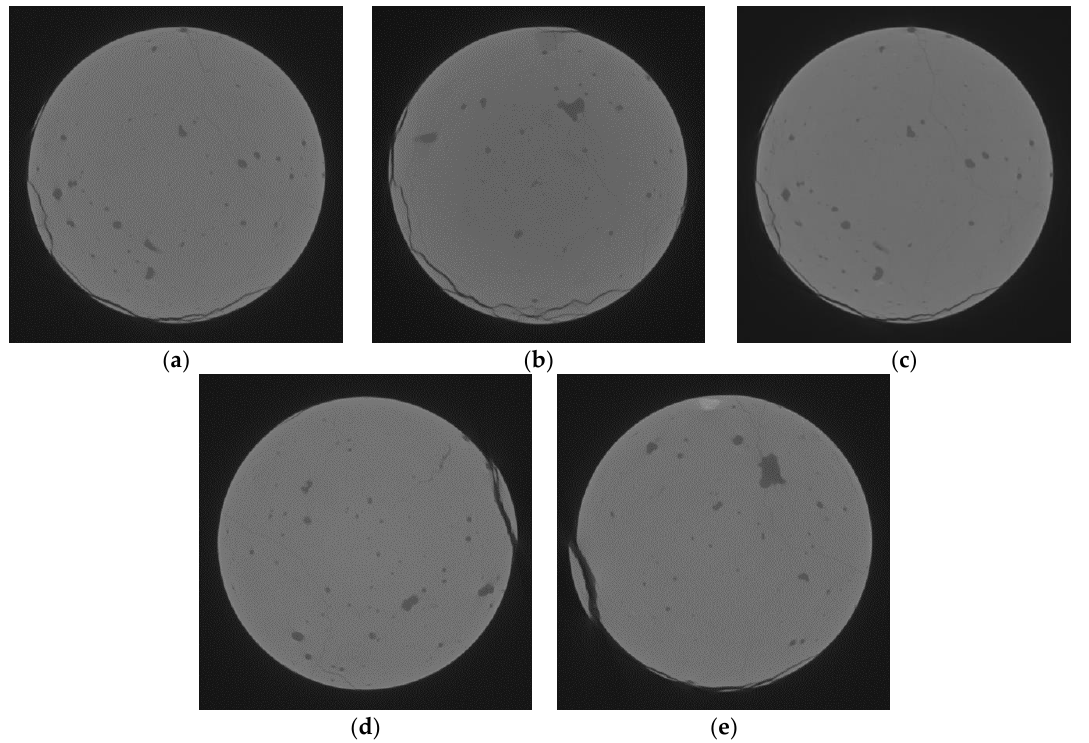
Figure 13. Examples of cracking in HPC specimens. L-Series under the five different sets of cycles: ( a ) 0 cycles; ( b ) 2000 cycles; ( c ) 20,000 cycles; ( d ) 200,000 cycles; ( e ) 2,000,000 cycles.